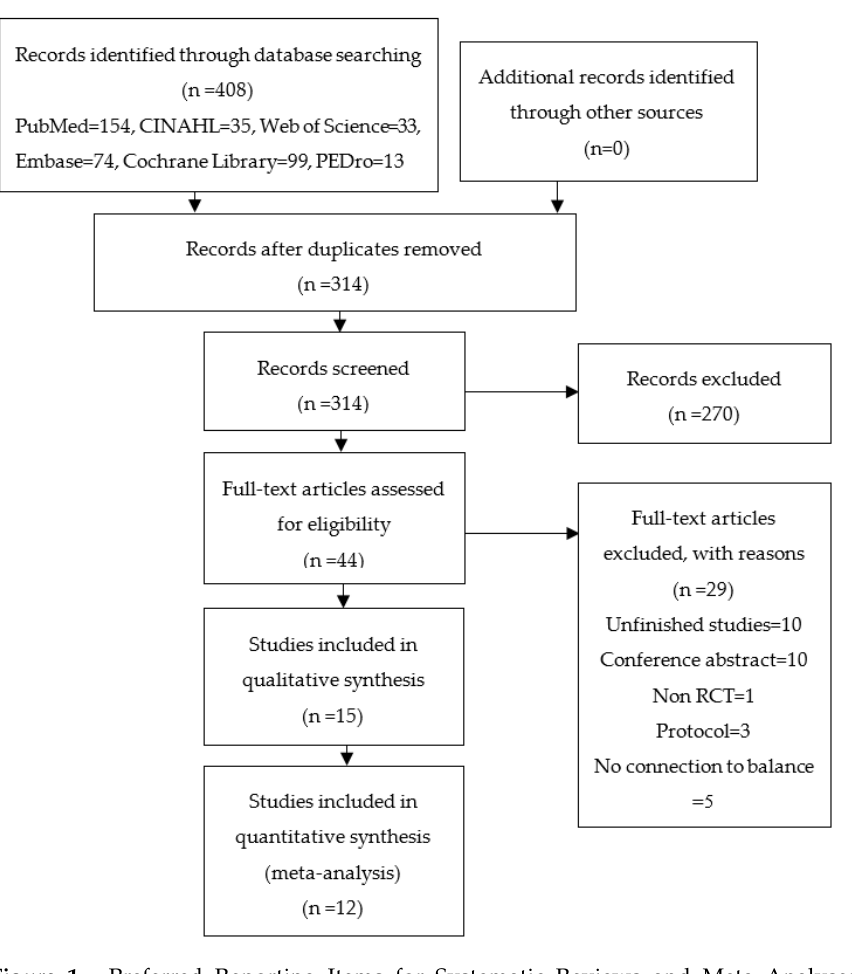
Figure 1. Preferred Reporting Items for Systematic Reviews and Meta Analyses (PRISMA) Flow Diagram.